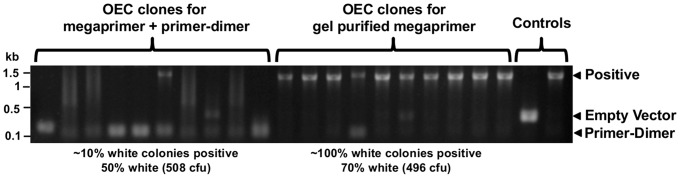
OEC does not tolerate primer-dimers.Megaprimer and primer-dimer contaminant or 1.4 kb LXR megaprimer alone were gel purified and used for OEC. Ten white colonies for each were screened by PCR across the cloning junctions.